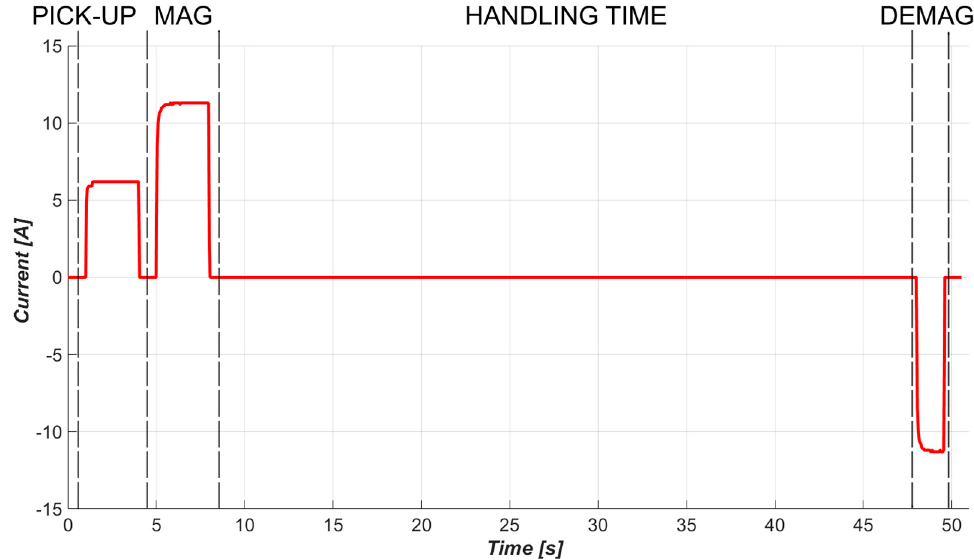
Figure 11. The Case 2 current trend for a complete cycle of the EP system, which starts with the pick-up phase.